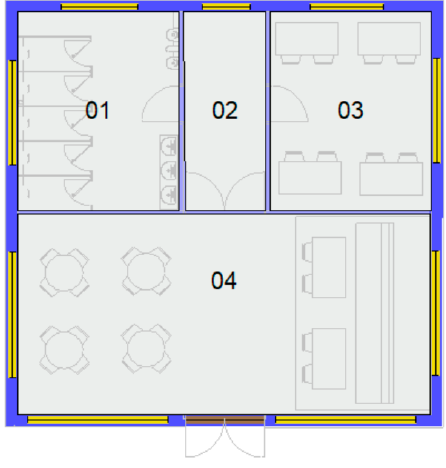
Figure 2. Floor layout for the proposed building. Table 1. Geometrical information of the proposed building.